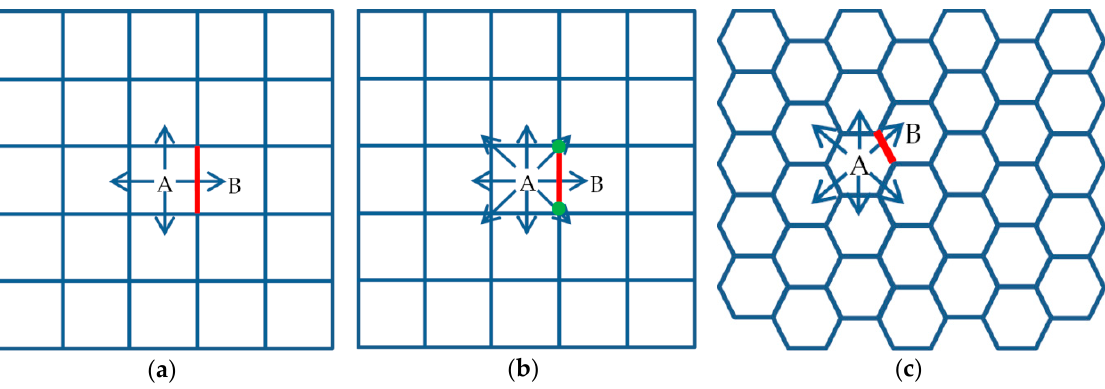
Figure 2. Three regular surface partitionings: ( a ) square configuration with rook adjacency; ( b ) square configuration with queen adjacency; ( c ) hexagonal configuration.